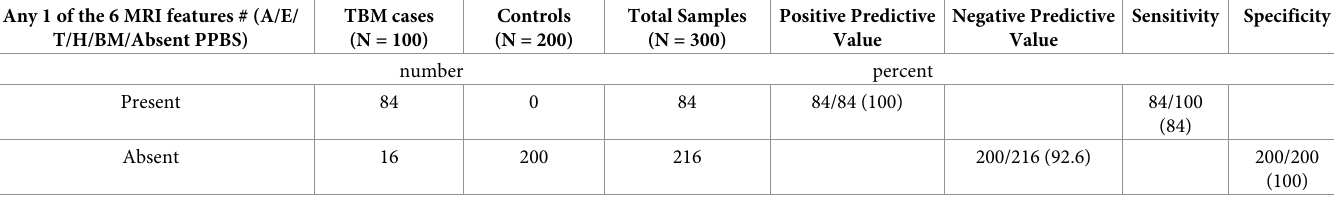
Table 4. Sensitivity and specificity of MRI for TBM with addition of “Absent PPBS” to A/E/T/H/BM. Any 1 of the 6 MRI features # (A/E/ T/H/BM/Absent